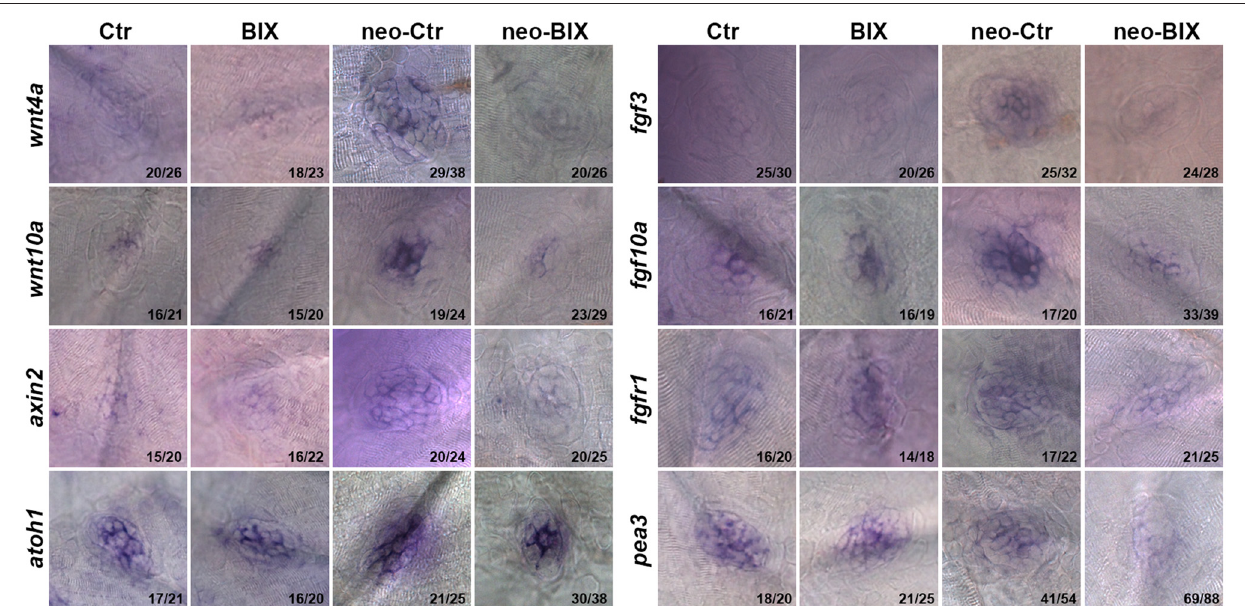
FIGURE 6 | BIX01294 significantly down-regulates the Wnt and Fgf signaling pathways . Localization of markers of Wnt ( wnt4a , wnt10a , and axin2 ) and Fgf signaling ( fgf3 , fgf10a , fgfr1 , pea3 , and atoh1a ) with whole mount in situ hybridization in 6 dpf control embryos and BIX01294-treated embryos with or without neomycin treatment for 1 h. Expression of wnt4a , wnt10a , axin2 , fgf3 , fgf10a , fgfr1 , pea3 , and atoh1a was significantly down-regulated during the neomycin-induced regeneration period after BIX01294 treatment for 24 h. The ratios of representative images to total images were labeled,